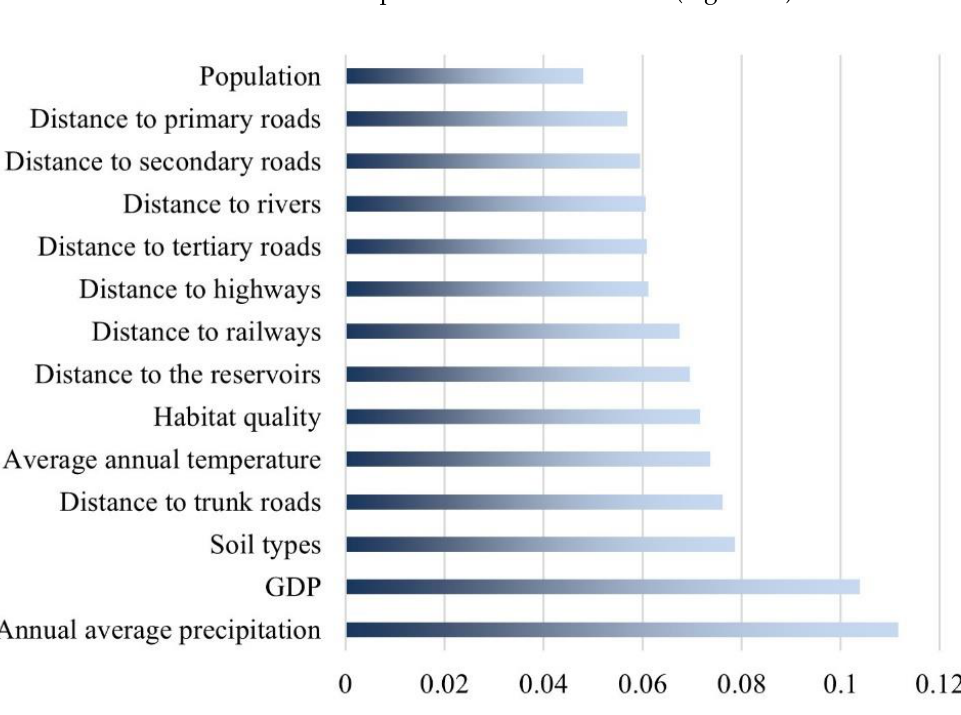
Figure 12. Contributions of factors to the growth of sloping cropland area. During the sloping cropland transition-out from 2005 to 2010, cropland was mostly transferred to forestland, built-up land, and water areas. By overlaying the elevation map and the area of sloping cropland transition-out (data not shown), we found that in the plain area with a low altitude, due to the intense human activities, cropland was more disturbed and a large amount of cultivated land with a scattered distribution was transferred to built-up land and water areas, whereas in the mountainous areas with low human activity, cropland was transformed into forestland, with a strip or group distribution (Figure